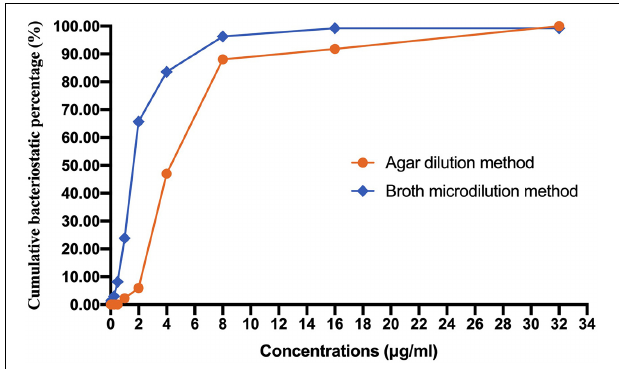
FIGURE 2 | Cumulative bacteriostatic percentage curves of the broth microdilution method and the agar dilution method.